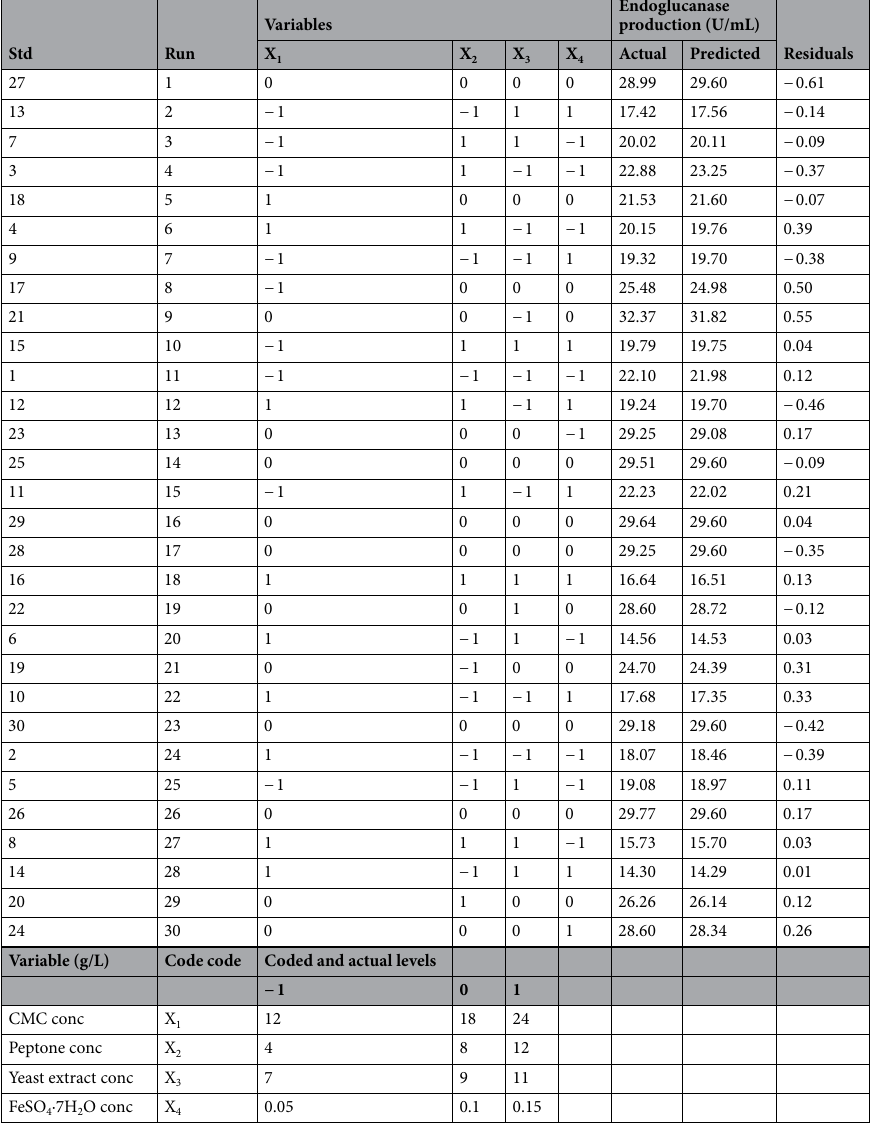
Table 4. Face-centered central composite design matrix representing endoglucanase production by Bacillus subtilis strain Fatma/1 as affected by CMC, yeast extract, peptone and FeSO 4 concentrations with coded and actual factor